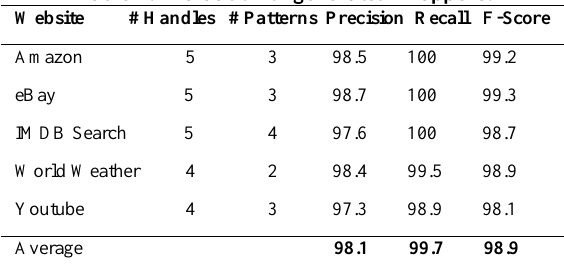
Table 1. Evaluation of generated